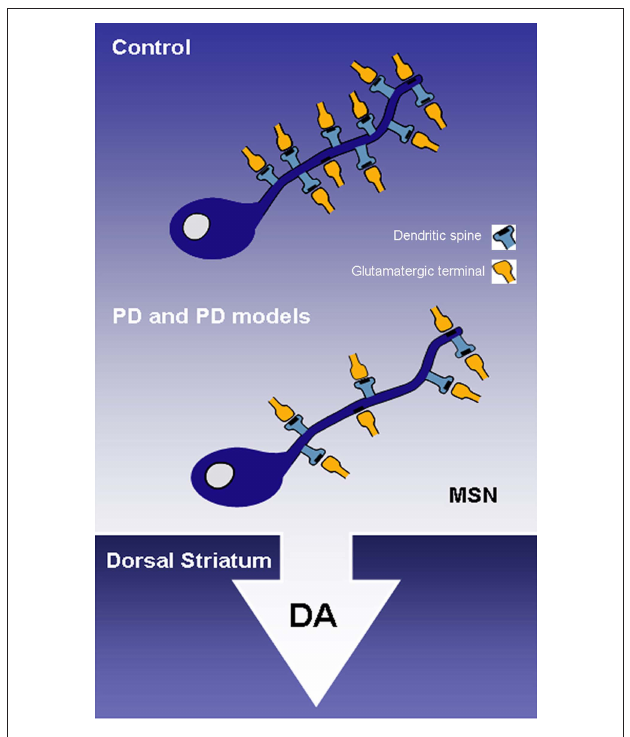
Figure 1 | The progressive striatal dopaminergic depletion in Parkinson’s disease (PD) patients and animal models of PD results in a severe spine loss in medium spiny neurons (MSNs) of the dorsal striatum. DA, dopamine; MSN, medium spiny neuron; PD, Parkinson’s disease.